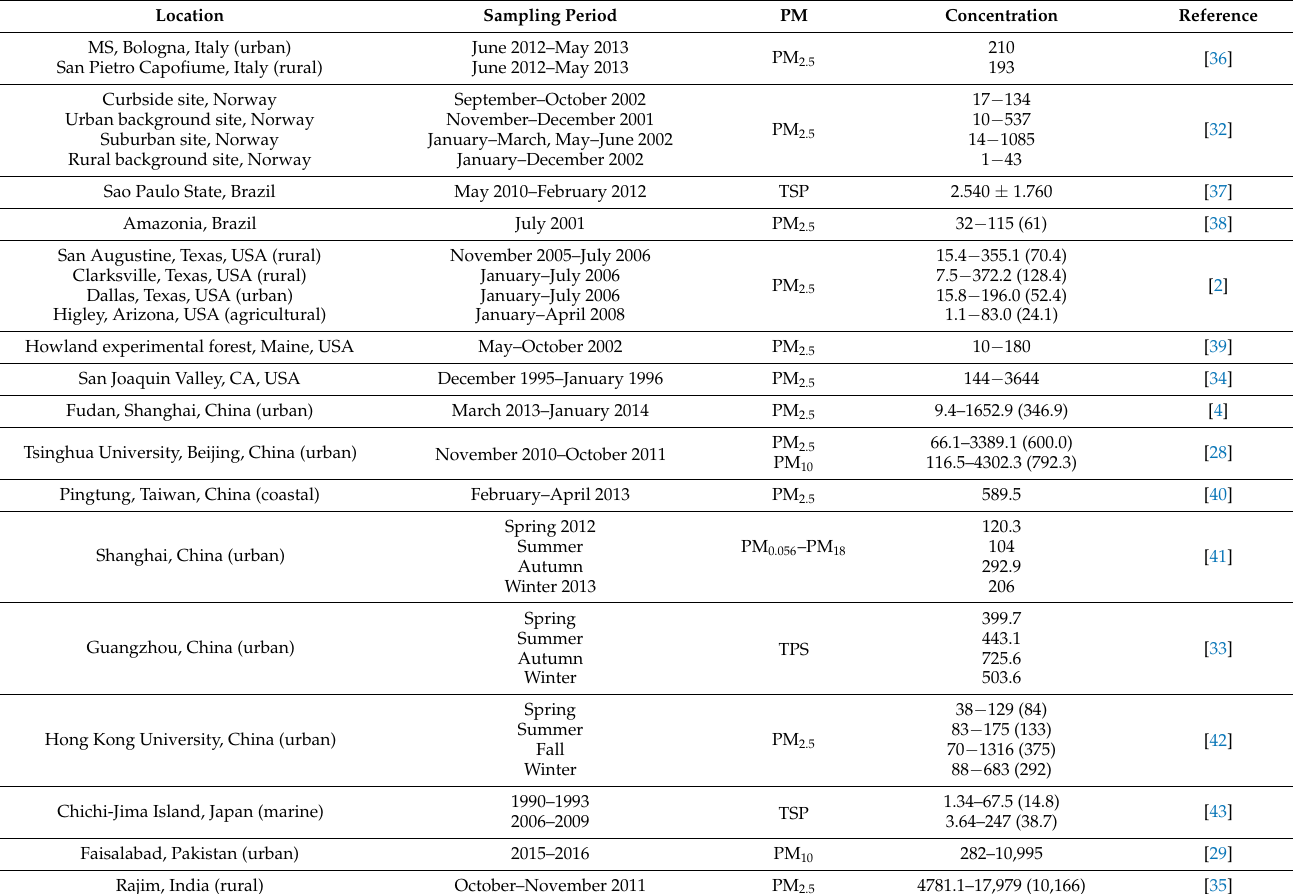
Table 5. Saccharide/sugar concentrations (ng · m − 3 ) reported in the literature for other locations. Location Sampling Period PM